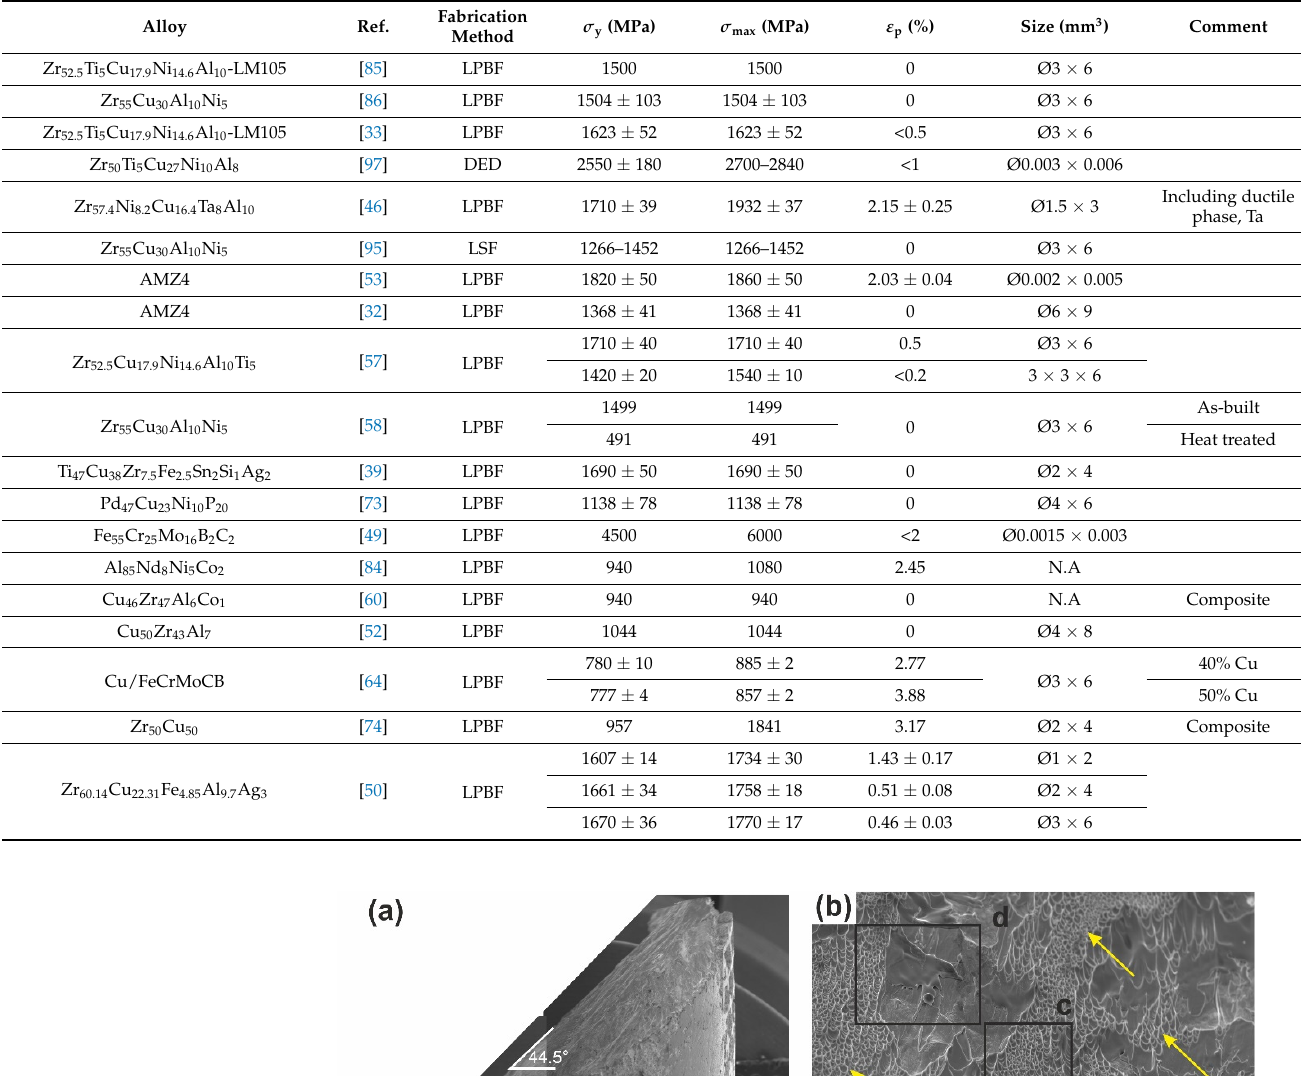
Table 4. Compression test results of BMGs fabricated via AM methods.